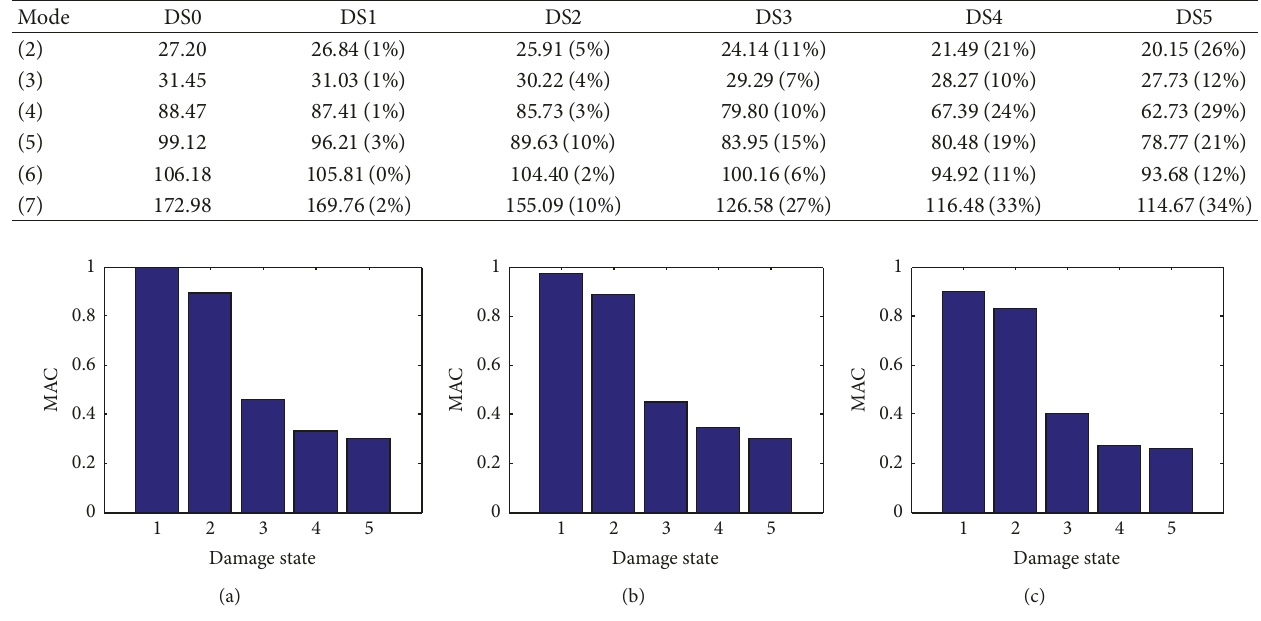
Figure 3: Effect of the noise in MAC relative to DS0 of a 16-dof model. (a) 0% noise, (b) 5% noise, and (c) 10% noise.